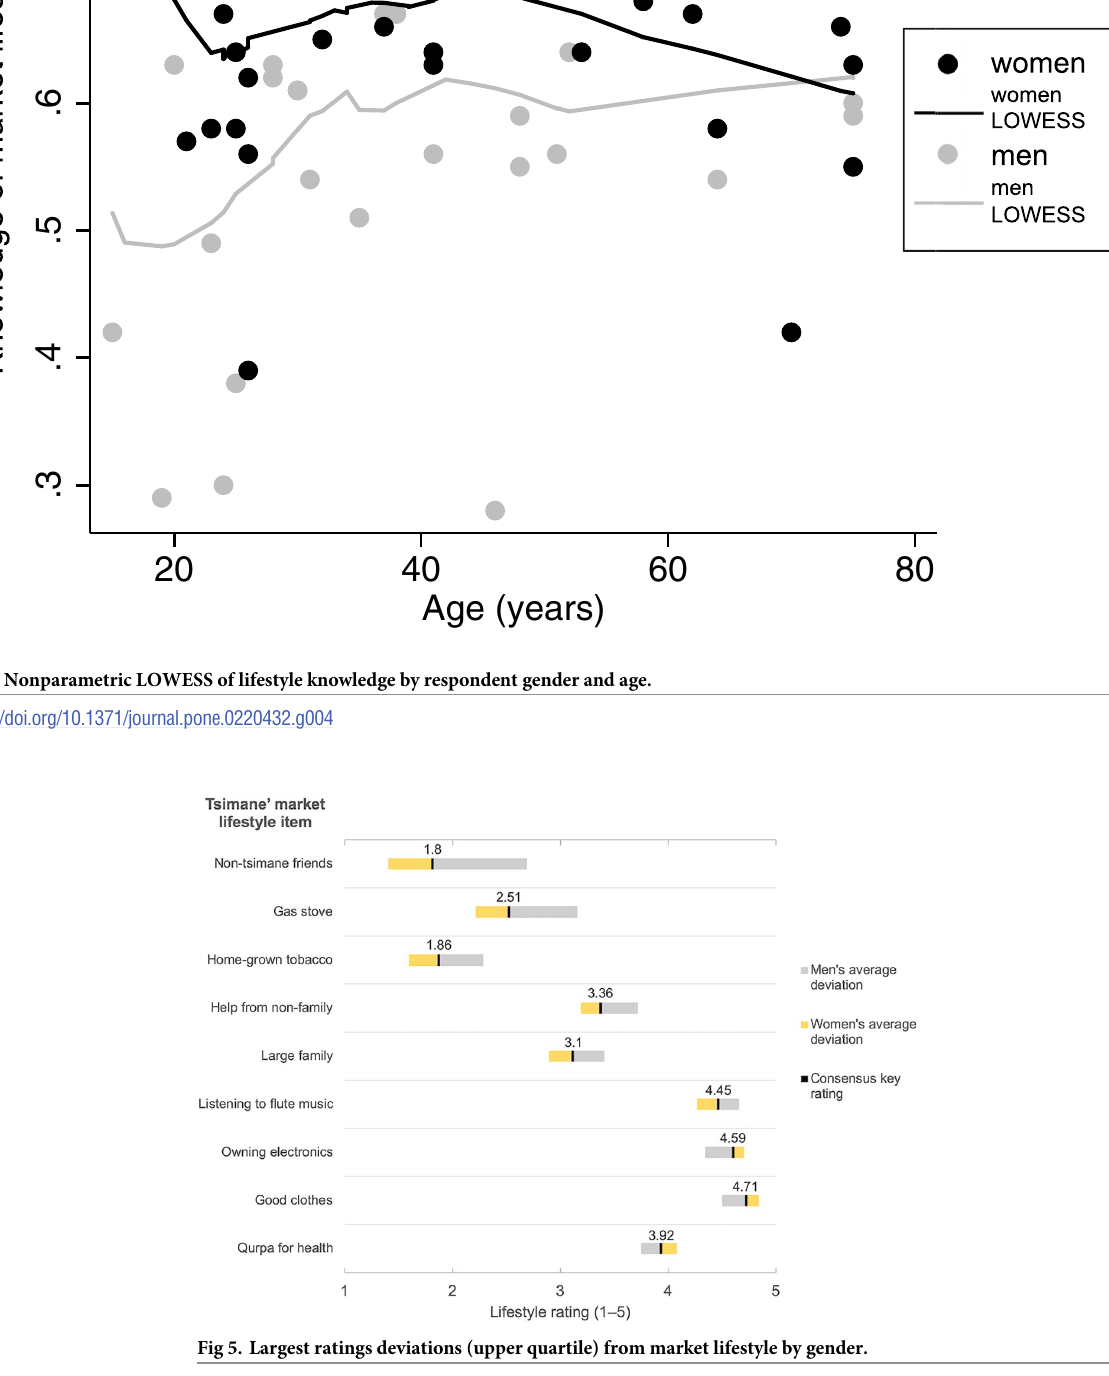
PLOS ONE | https://doi.org/10.1371/journal.pone.0220432 September 3,